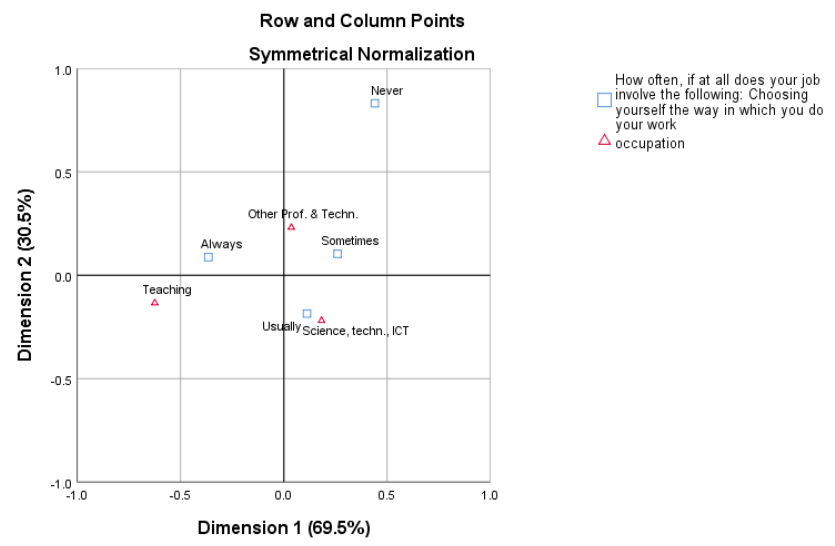
Figure 2. Correspondence analysis between occupation categories and frequency of learning new things at work. Source: authors calculation on data from ESJ (Wave 1) [70]